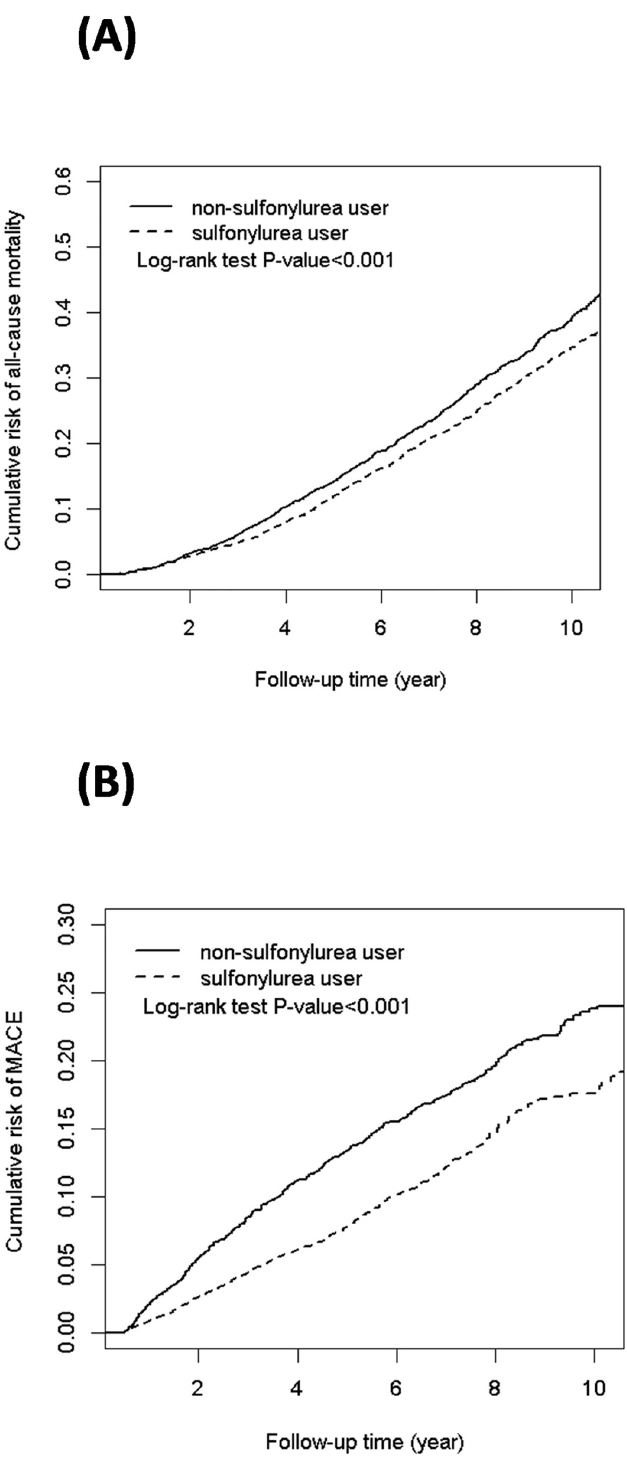
Fig 2. Cumulative incidence curves of (A) all-cause mortality and (B) major adverse cardiovascular events (MACE) between sulfonylurea users and nonusers in patients with diabetes and compensated cirrhosis.